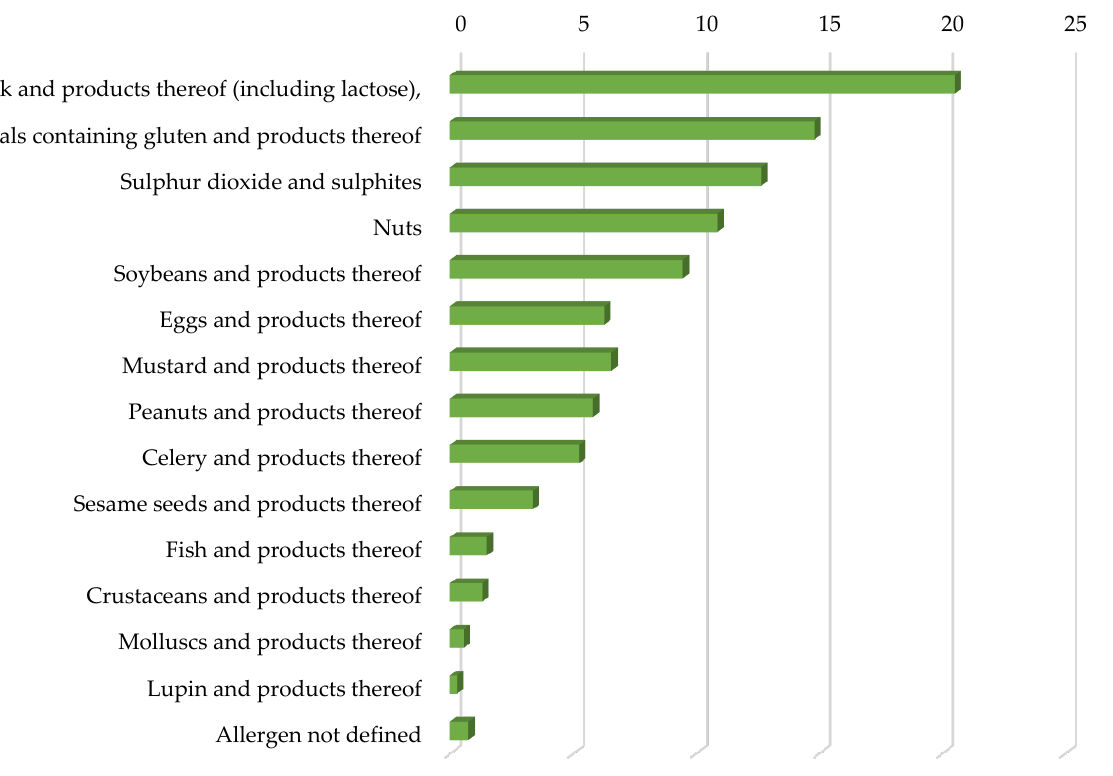
Figure 2. Percentage of total notifications per mandatory declaration allergen in the EU between 1 January 2018 and 31 December 2021.